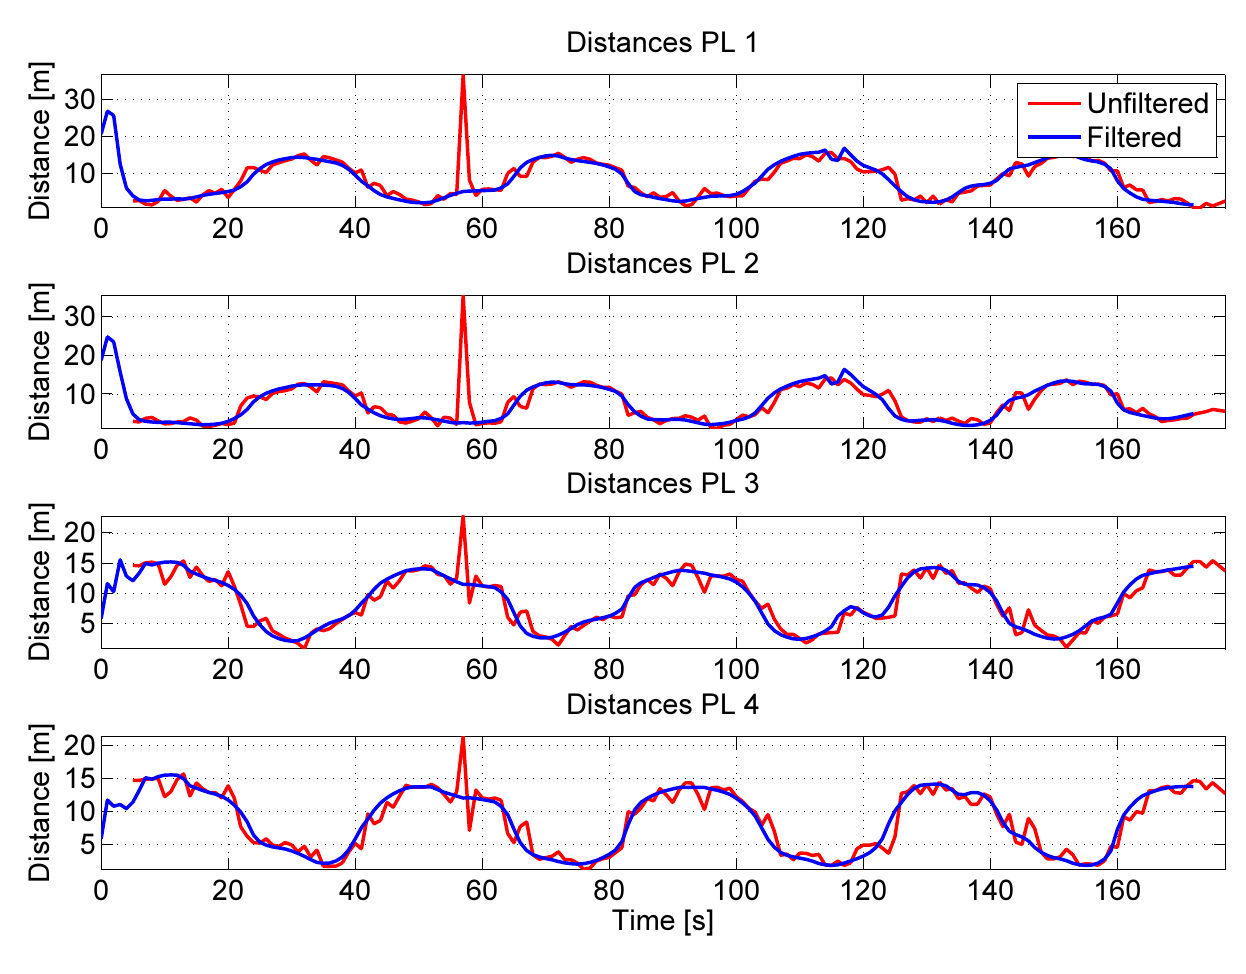
Figure 14. Distances estimated from the C/N pseudolites. Filtering clearly improves the performance of the